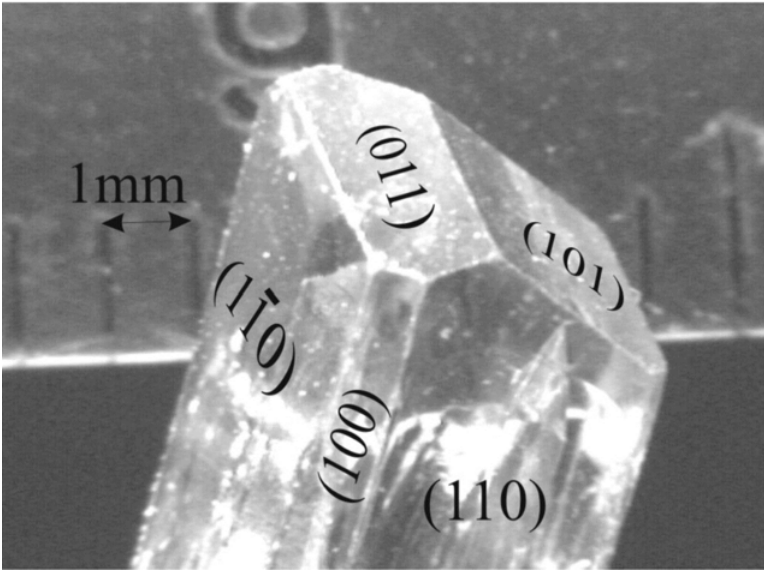
Figure 2 . Photograph of a SnO